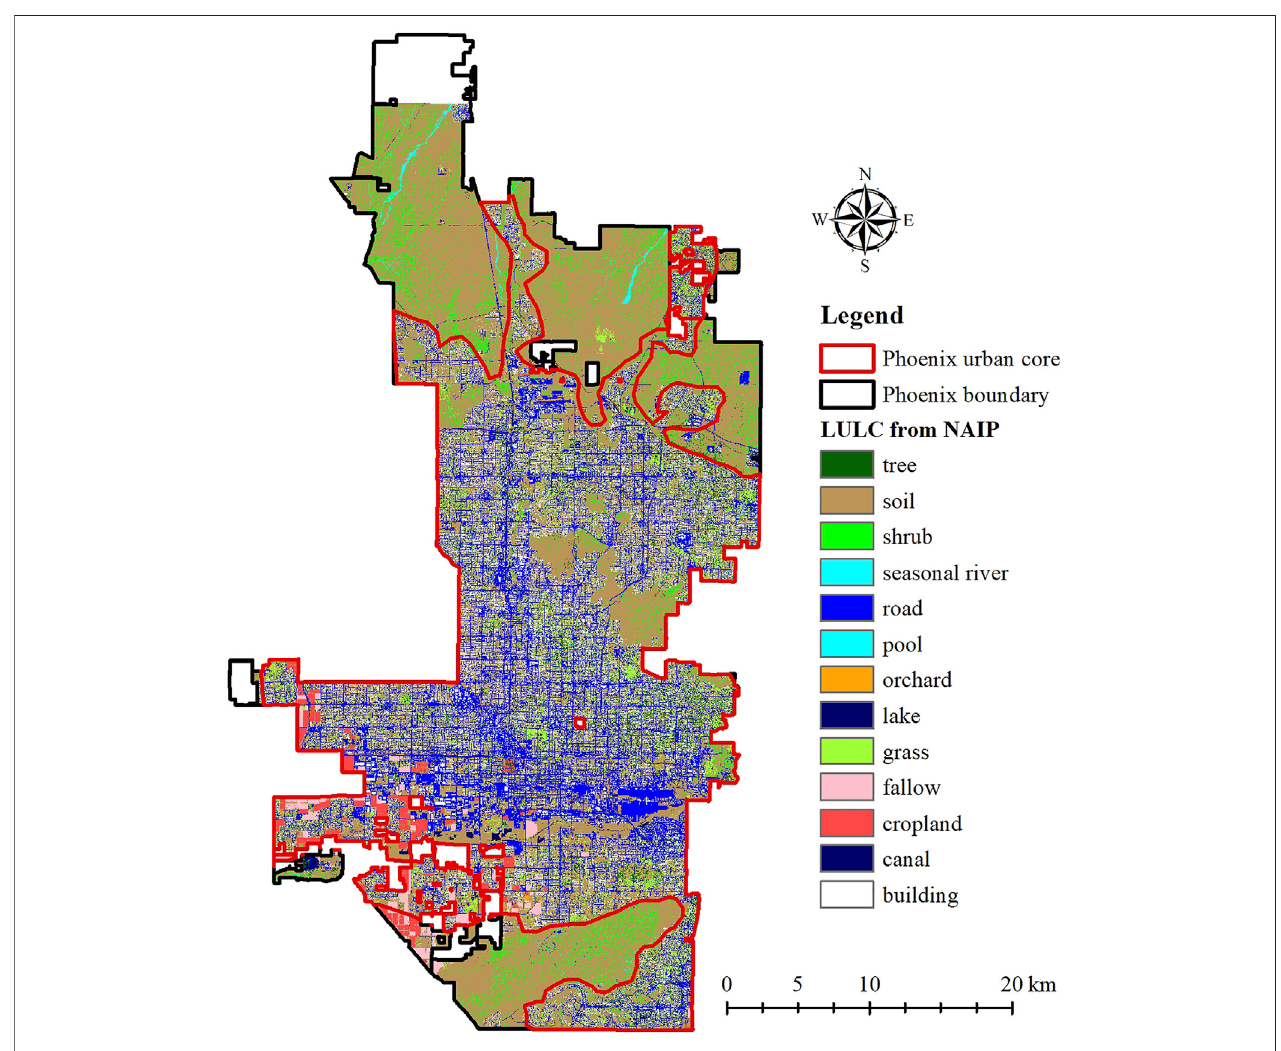
FIGURE 1 | Land use and land cover map derived from 1-m resolution data acquired by the National Agricultural Imagery Program (NAIP) within the city limits of Phoenix, Arizona.